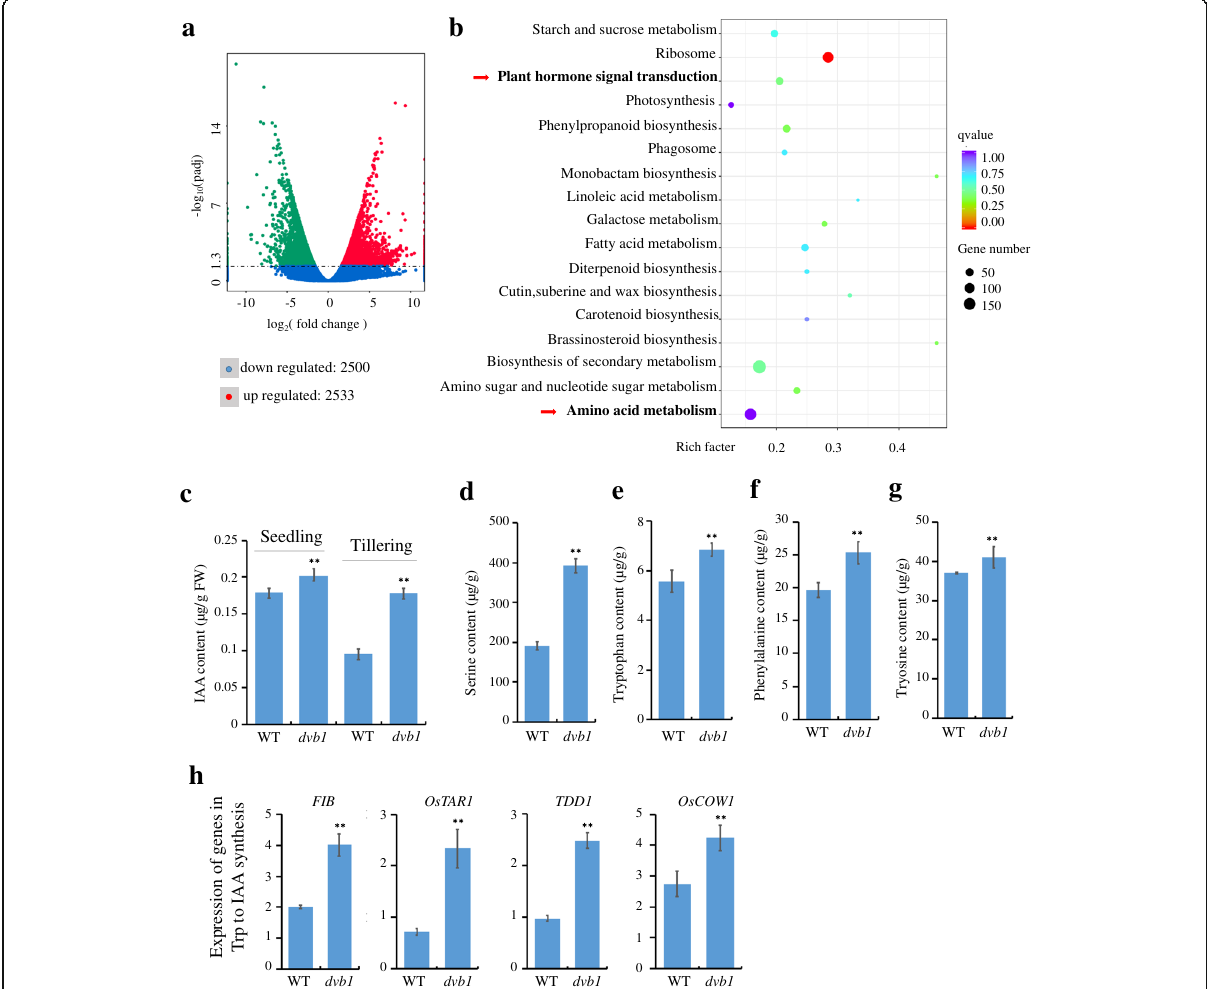
Fig. 7 DVB1 involvement in the auxin synthesis pathway. a , b Volcano plot of genes differentially expressed in leaves at tillering stage between the dvb1 mutant and the wild type ( a ) and KEGG pathway enrichment scatterplot of differentially expressed genes ( b ) from RNA-sequencing data. c IAA content of leaves at seedling and tillering in the wild type and dvb1 plants . d - g Serine ( d ), tryptophan ( e ), phenylalanine ( f ) and tyrosine ( g ) contents of leaves at tillering stage in the wild type and dvb1 plants. h Expression of genes involved in auxin synthesis of leaves at tillering stage in the wild type and dvb1. Values represent means ± SD from 6 biological samples. Asterisks indicate the significance of differences between the wild type and dvb1 as determined by Student ’ s t -test (*, 0.01 ≤ P < 0.05; **, P <